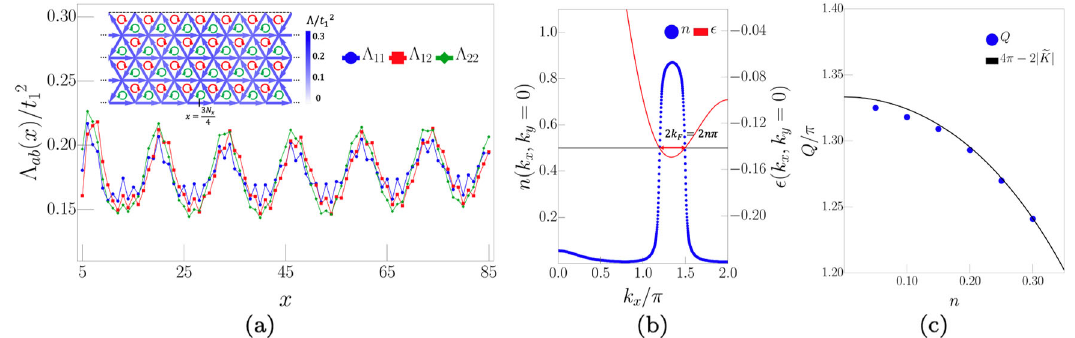
Fig. 3 Evidences for broken symmetries. a The current-current correlator for a two-leg cylinder of length N x = 240 and electron density n = 0.15. The inset shows the long-distance current correlation pattern around x = 3 N x /4 of a four-leg cylinder of length N x = 100 and electron density n = 0.15, with reference bond at x = N x /4. b The occupation number in momentum space of a two-leg cylinder with length N x = 240 and electron density n = 0.15. The Fermi points match those of the noninteracting band ϵ ( k ) de fi ned in Eq. (3) with width 2 k F = 2 n π = 0.3 π . The interval k x ∈ ( − 2 π , 0) mirrors the range shown. c Despite strong interactions, there is good agreement between the extracted pair momentum listed in Fig. 2b and the center of the noninteracting band structure estimated in Eq. (4).